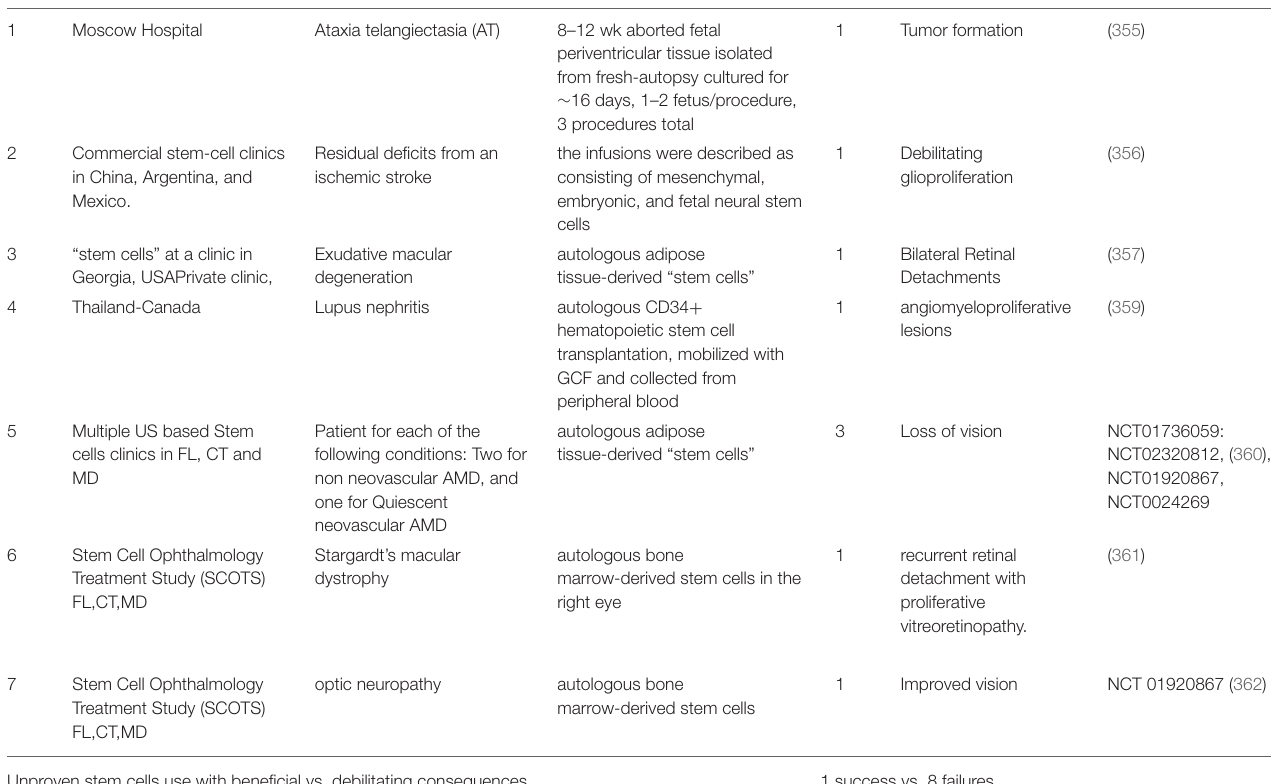
TABLE 3 | Unproven application of cell